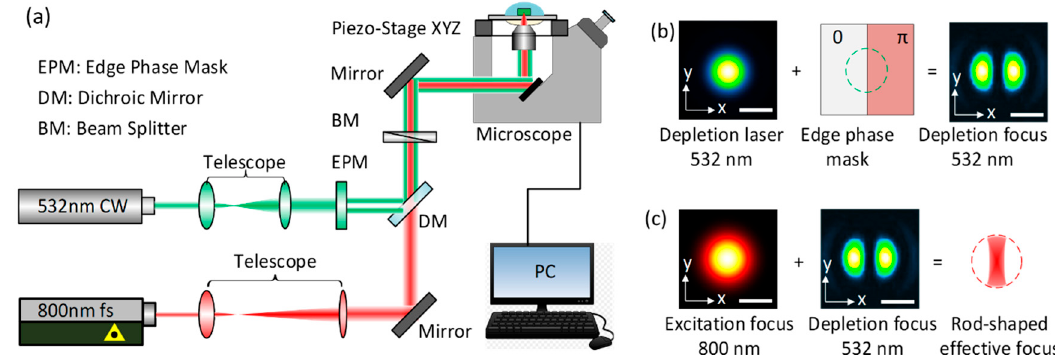
Figure 1. ( a ) Schematic diagram of simulated emission depletion (STED) direct laser writing. ( b ) Creation of the twin-oval depletion focus by inserting a half-space edge phase mask into the depletion beam. ( c ) Formation of rod-shaped effective focus spot, which was a combination of Gaussian excitation focus coinciding with twin-oval depletion focus, scale bar 200 nm.